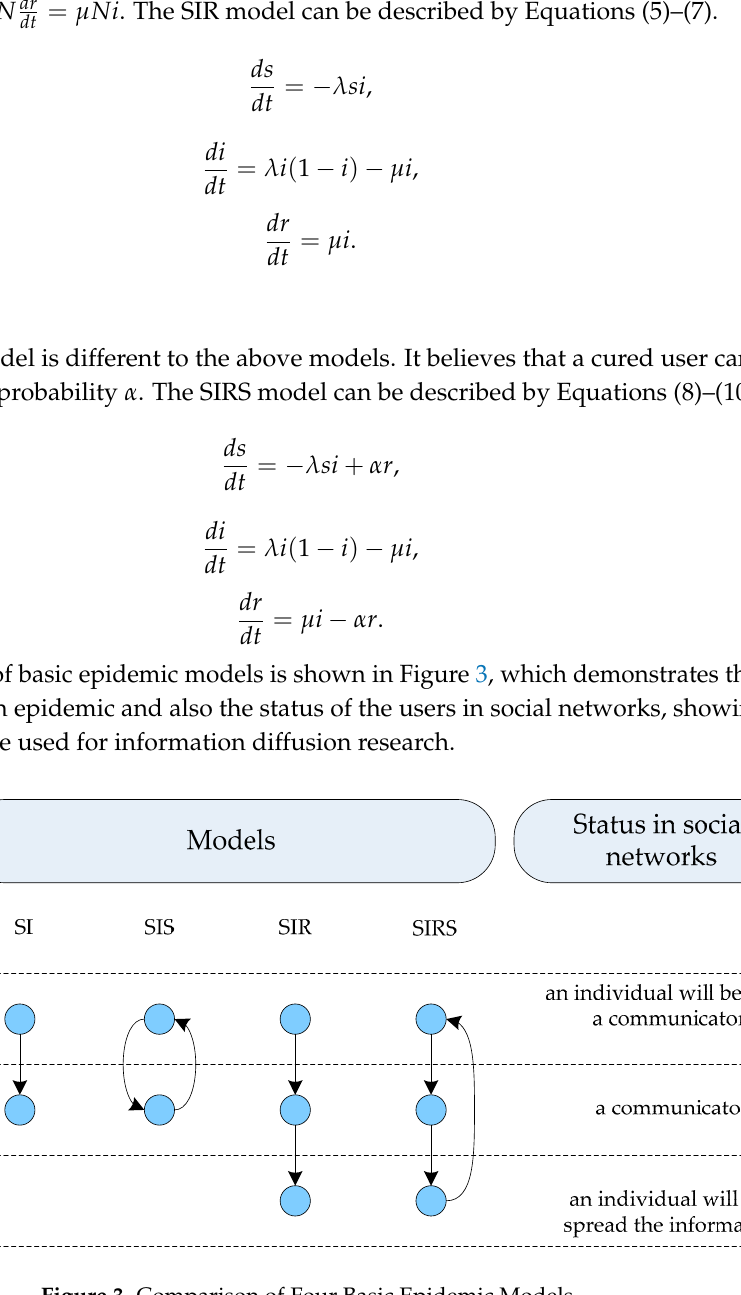
Figure 3. Comparison of Four Basic Epidemic